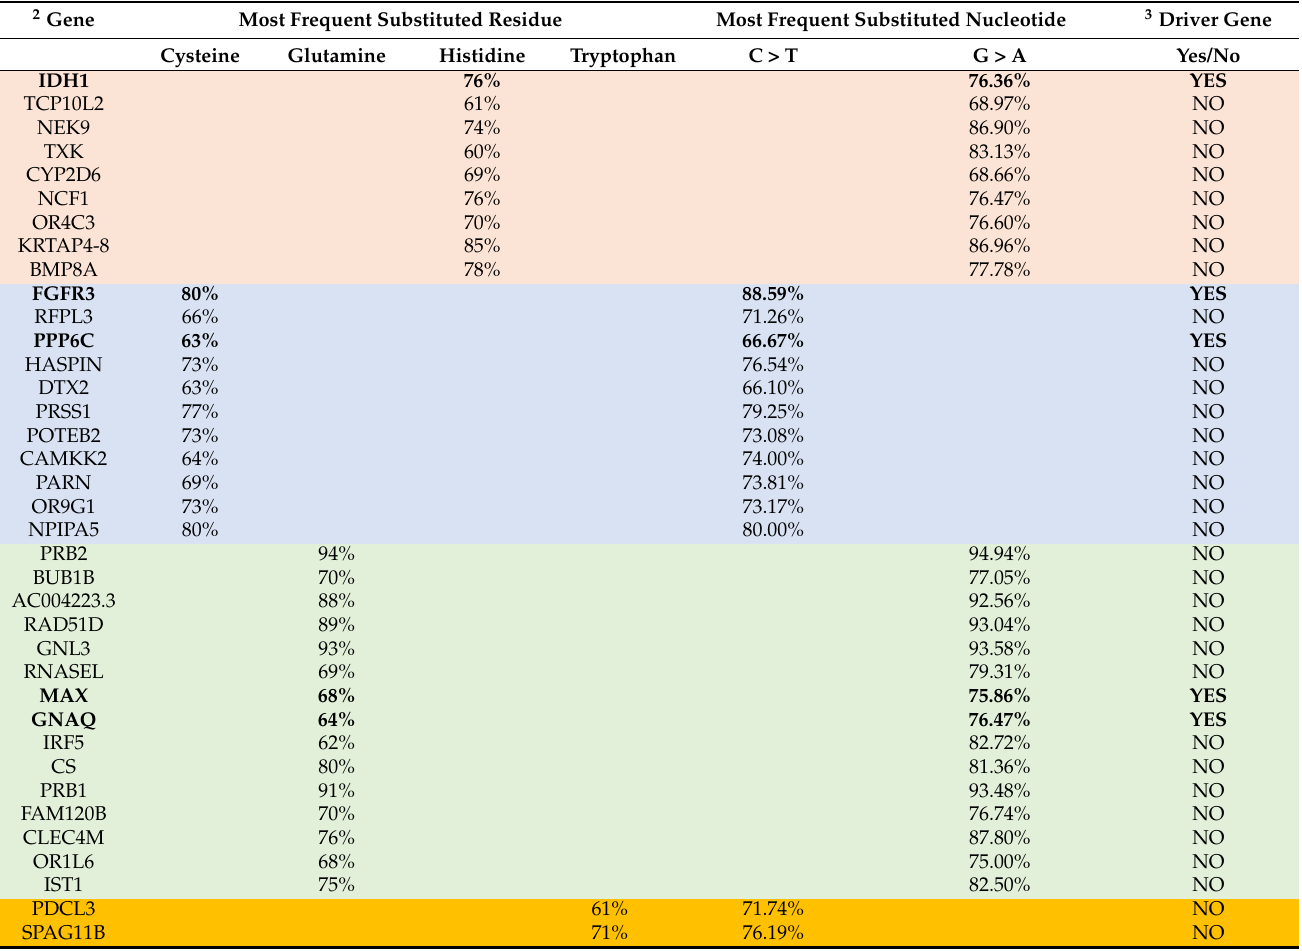
1 The table colors correspond to arginine substitution biases towards the four amino acids (cysteine, histidine, glutamine and tryptophan). 2 Only genes with a substitution bias over 60% are shown. Please see Supplementary Table S3 for further details. 3 Genes in bold are characterized as driver by Martinez-Jimenez et al.